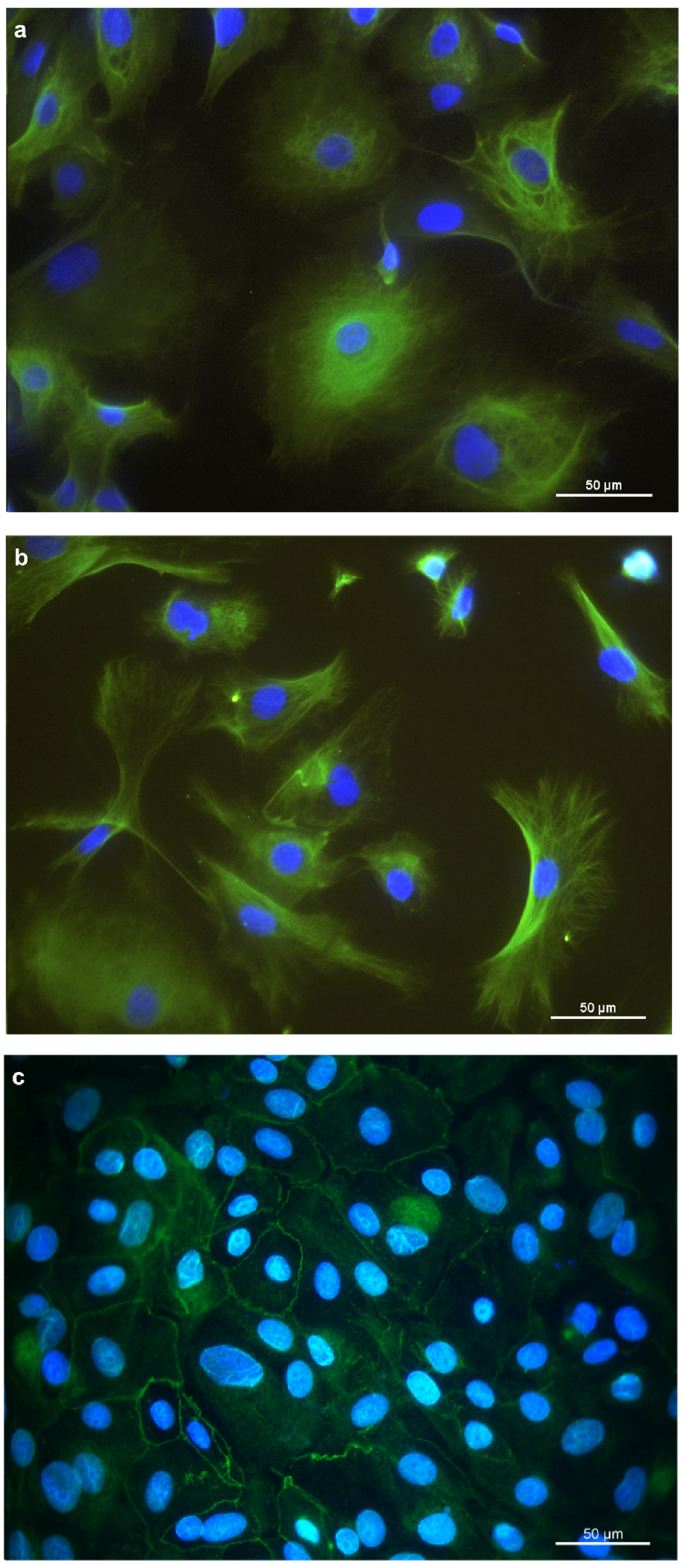
Figure 2. Immunostaining of RECs in chamber slides with ( a ) cytokeratin as an epithelial cell marker, ( b ) vimentin as a mesenchymal marker, and ( c ) occludin, a tight junction protein. DAPI was used as a cell nuclei counterstain.